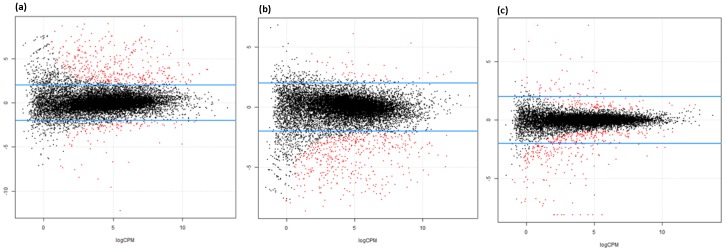
Cox-Reid common dispersion between adipose depots.(a) Omental vs. Intramuscular, (b) intramuscular vs. subcutaneous, and (c) omental vs. subcutaneous.